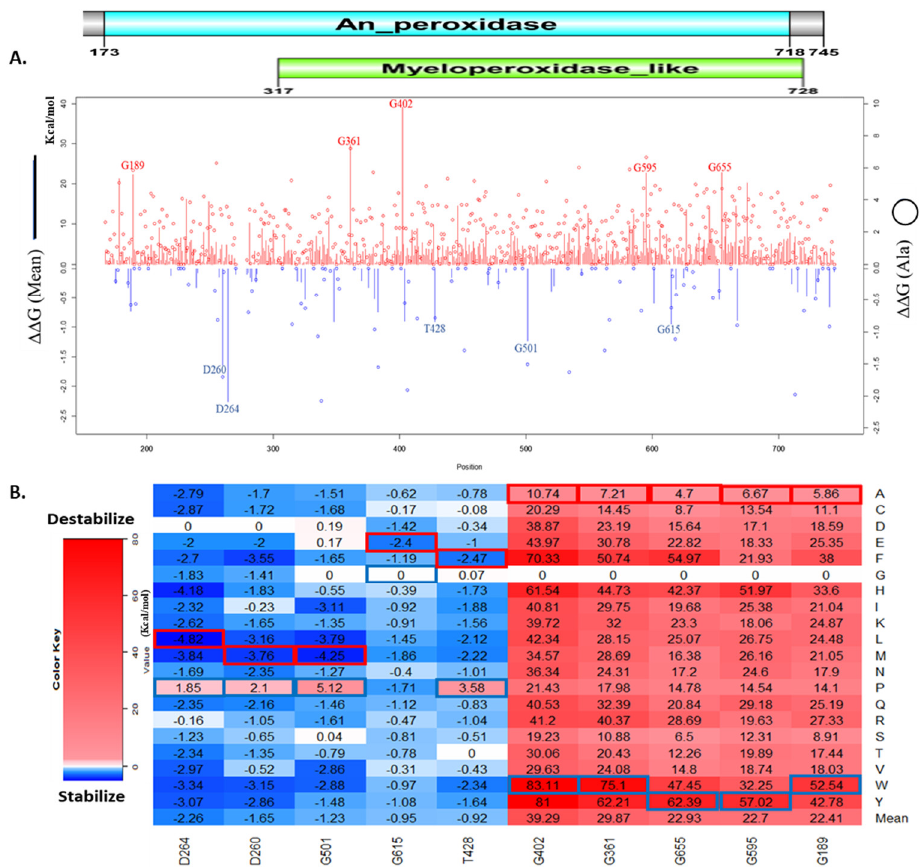
Figure 2. Effects of missense mutations on MPO stability. ( A ) line chart of residues 167 − 744 showing their mean folding energy changes (ΔΔG) in vertical bars and ΔΔG of alanine substitutions in circles. The An_peroxidase (Aqua bar) and the Myeloperoxidase (green bar) domains represent the superfamily and family domains, respectively; ( B ) heatmap of top 5 stabilizing and top 5 destabilizing mean ΔΔG. The blue rectangle represents maximum values and the red rectangle represents minimum values for each residue position. Key residues are highlighted on the line chart and heatmap.